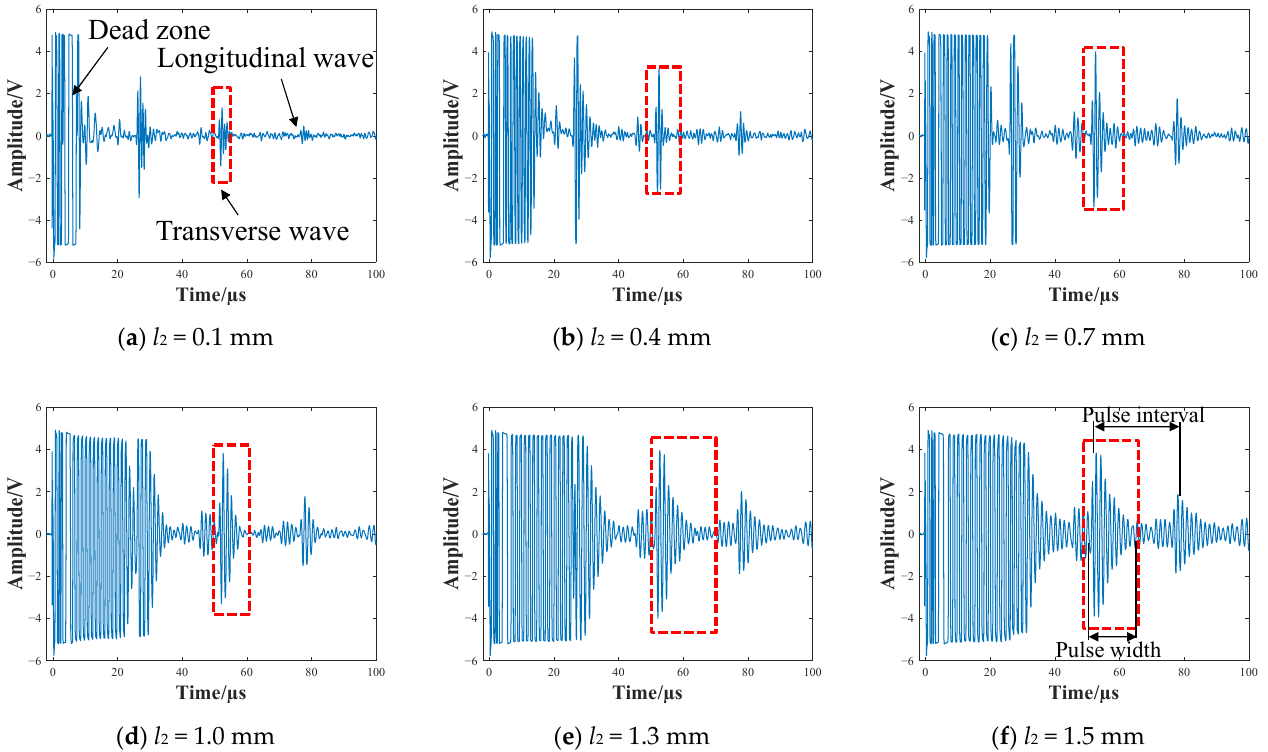
Figure 8. The signals of the 173-turn coil at the backplate position of ( a ) 0.1 mm, ( b ) 0.4 mm, ( c ) 0.7 mm, ( d ) 1.0 mm, ( e ) 1.3 mm, ( f ) 1.5 mm, respectively.